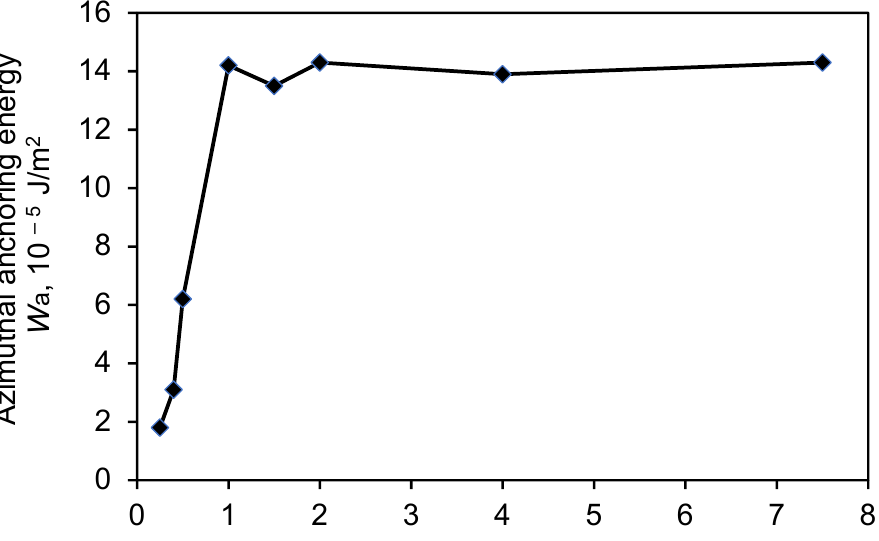
Figure 1. Azimuthal anchoring energy of nematic LC versus the exposure energy.